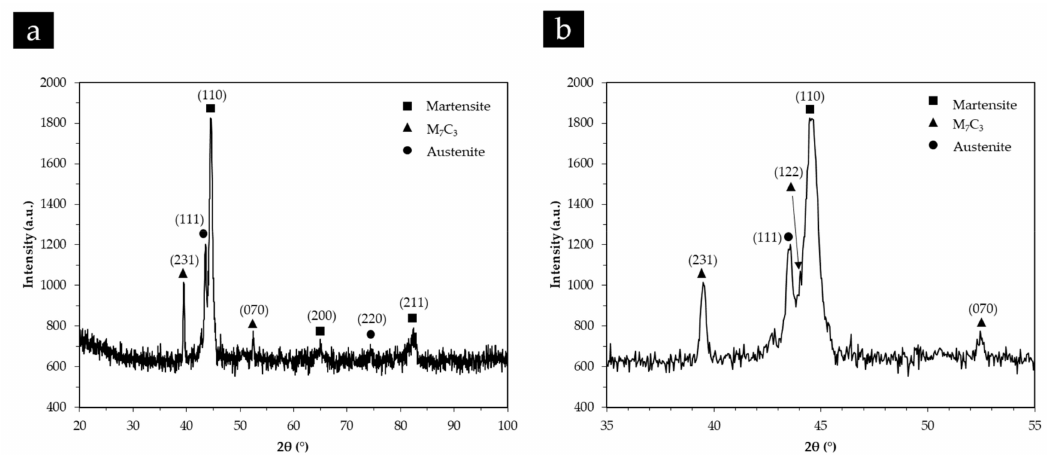
Figure 10. X-ray di ff raction (XRD) patterns of the high-chromium white cast iron in the as-cast condition in the 2 θ range of 20 ◦ –100 ◦ ( a ) and 35 ◦ –55 ◦ ( b